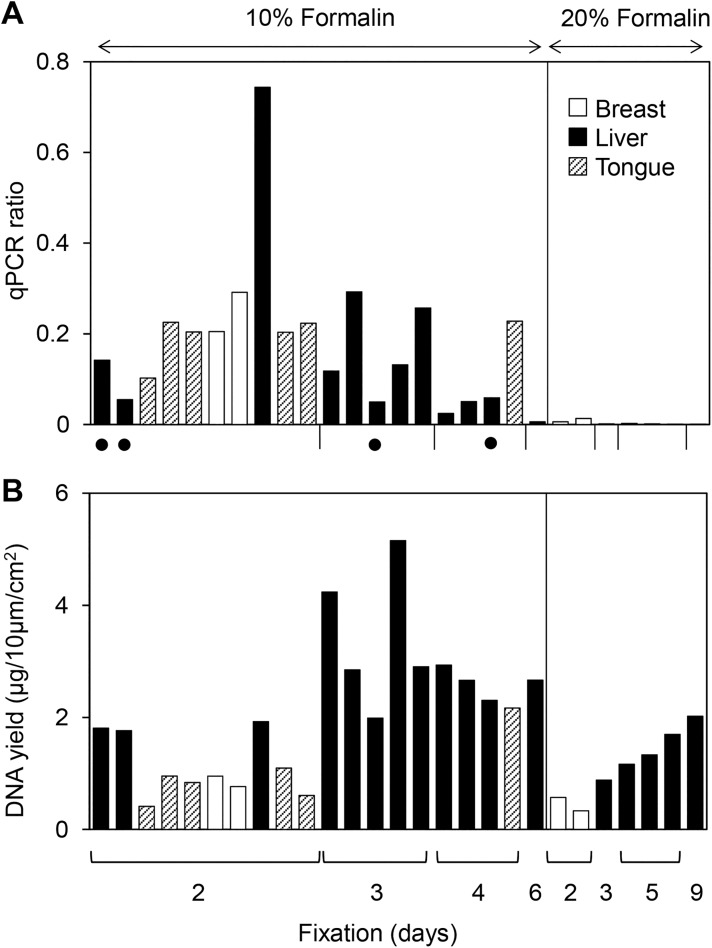
DNA quality and quantity of various clinical diagnostic FFPE tissues.DNA was extracted from 27 FFPE samples of normal breast, normal liver and tumorous tongue and then qualified and quantified. The samples were divided into two groups to test the formalin concentration and subdivided for the number of fixation days. Six tongue tissues were fixed with 10% neutral buffered formalin. The four samples with black dots were fixed at a temperature higher than 25°C. (A) The DNA quality was determined by qPCR of human GAPDH (93 bp), and the results are expressed as the ratio to fresh-frozen DNA. (B) The DNA yield was determined using an UV spectrophotometer, and the results are expressed as DNA quantity per cm2 of tissue area with 10 μm thickness.